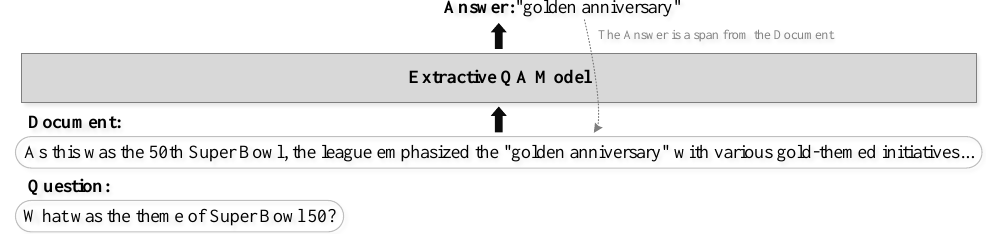
Figure 1. An extractive question-answering system takes a question and a document as the input and extracts a span from the document as the output